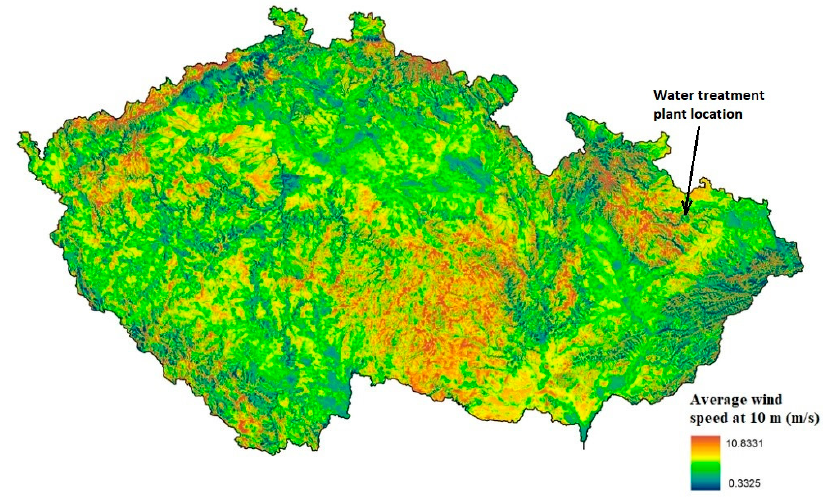
Figure 6. Average wind speed at 10